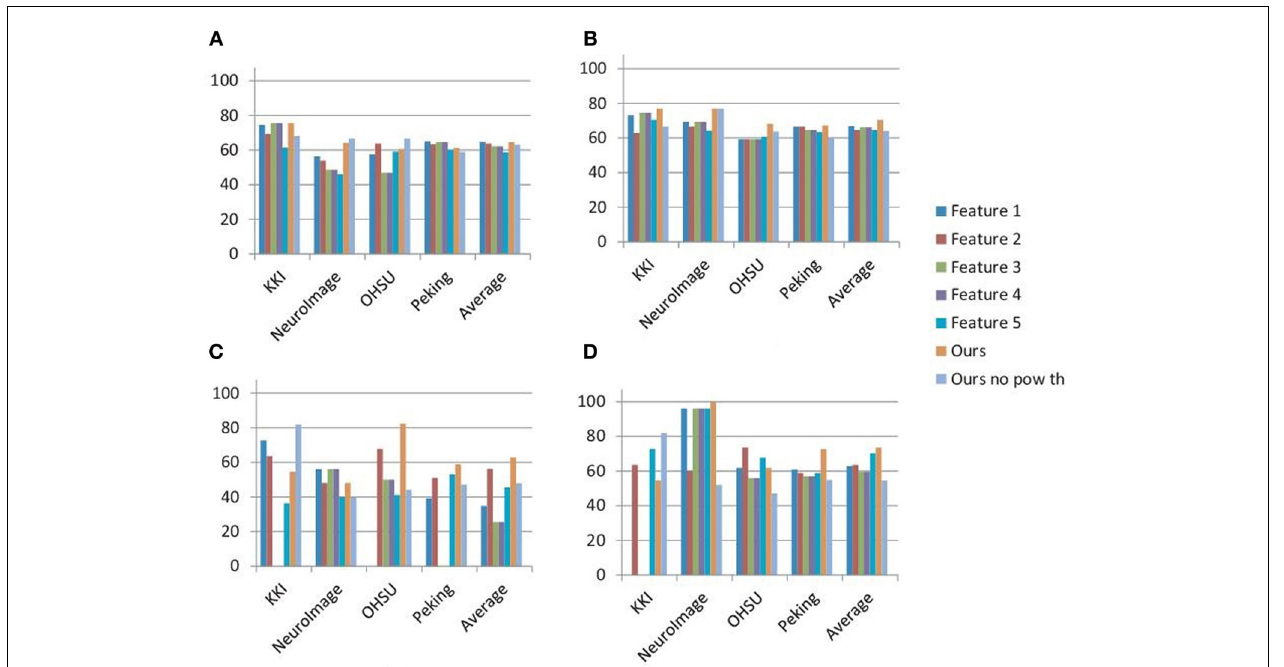
FIGURE 3 | Summary of the results: figure plots the best detection rates achieved on all the training and test sets using five commonly used network features implemented in the BCT, our method and our method without the high power voxel selection step. Features 1–5 are the degree, topological overlap, clustering coefficient, local efficiency and rich